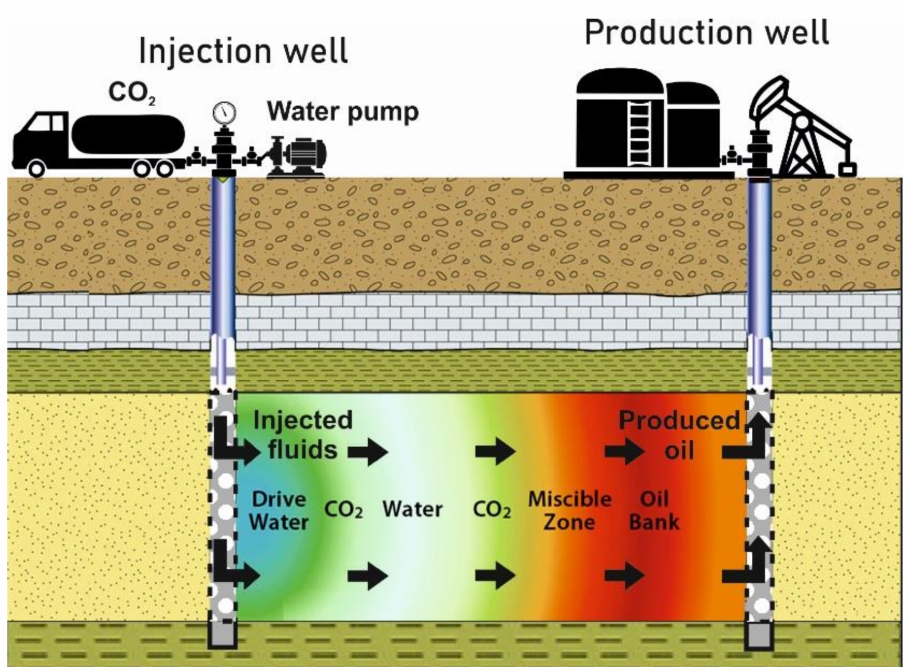
Figure 1. General scheme of WAG injection